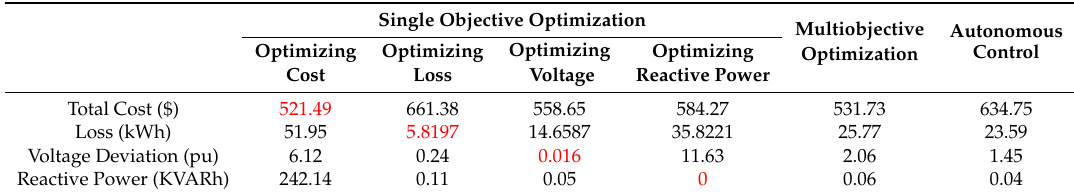
Table 2. Comparison of the results between single objective optimization and multi-objective optimization for grid-connected operation.